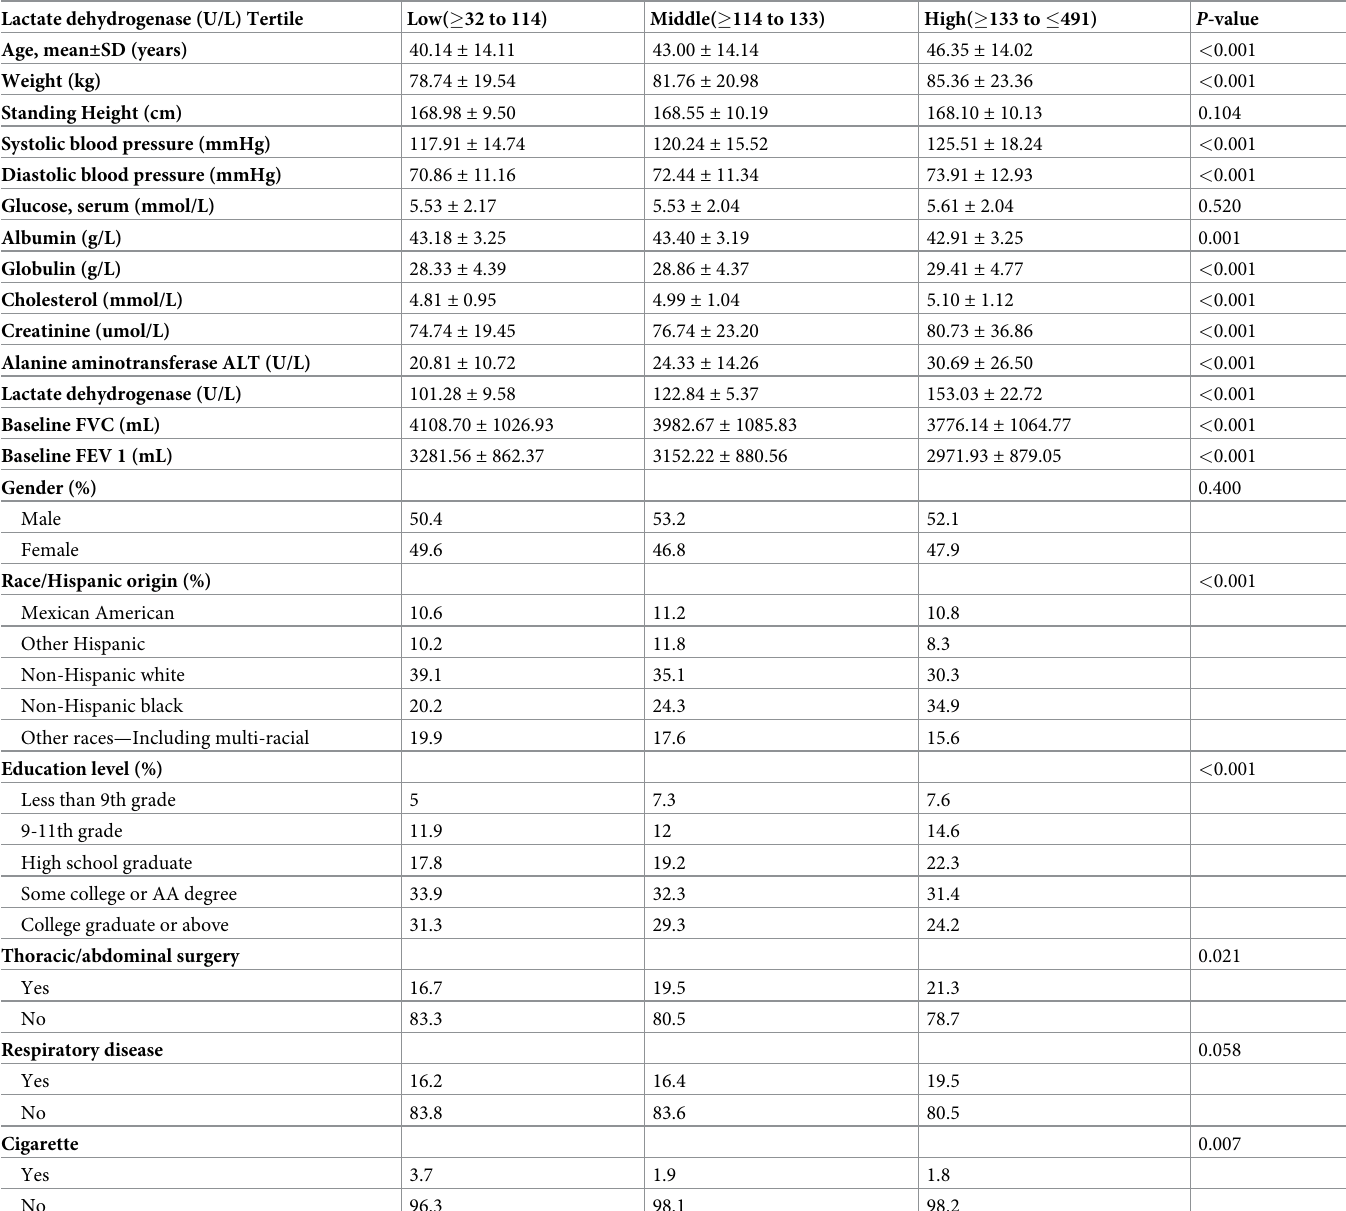
Table 1. Baseline characteristics of participants (N =